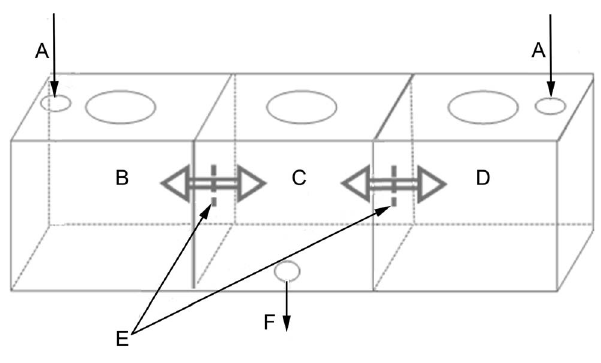
Figure 1. A schematic diagram of the three chamber system used to study mosquito behavior. Each chamber was 30.5 cm 6 30.5 cm 6 30.5 cm (28.4 L) with a 10 cm hole cut into a removable acrylic lid. A: lab air supply (5 L/min) measured with a rotameter, B: metal treatment chamber, C: acrylic mosquito introduc- tion chamber, D: metal control chamber, E: closable funnels opened during exposures studies to allow mosquitoes, air flow, and airborne chemical to move between the chambers, F: vacuum exhaust (10 L/ min).